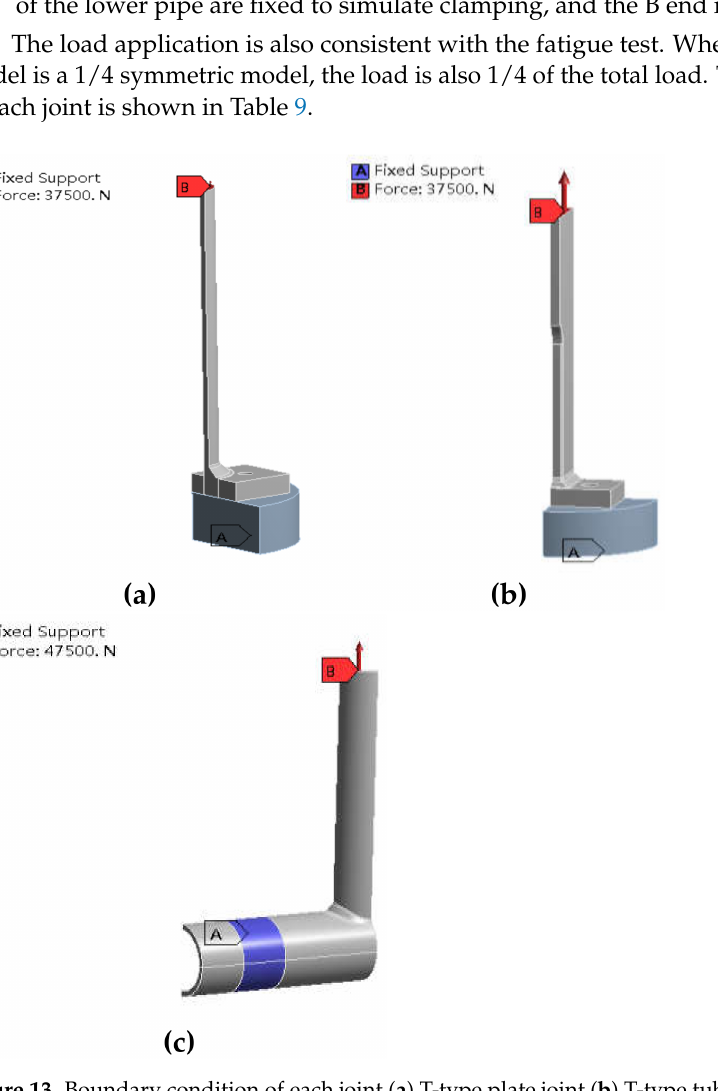
Figure 13. Boundary condition of each joint ( a ) T-type plate joint ( b ) T-type tube-plate joint ( c ) T-type tube